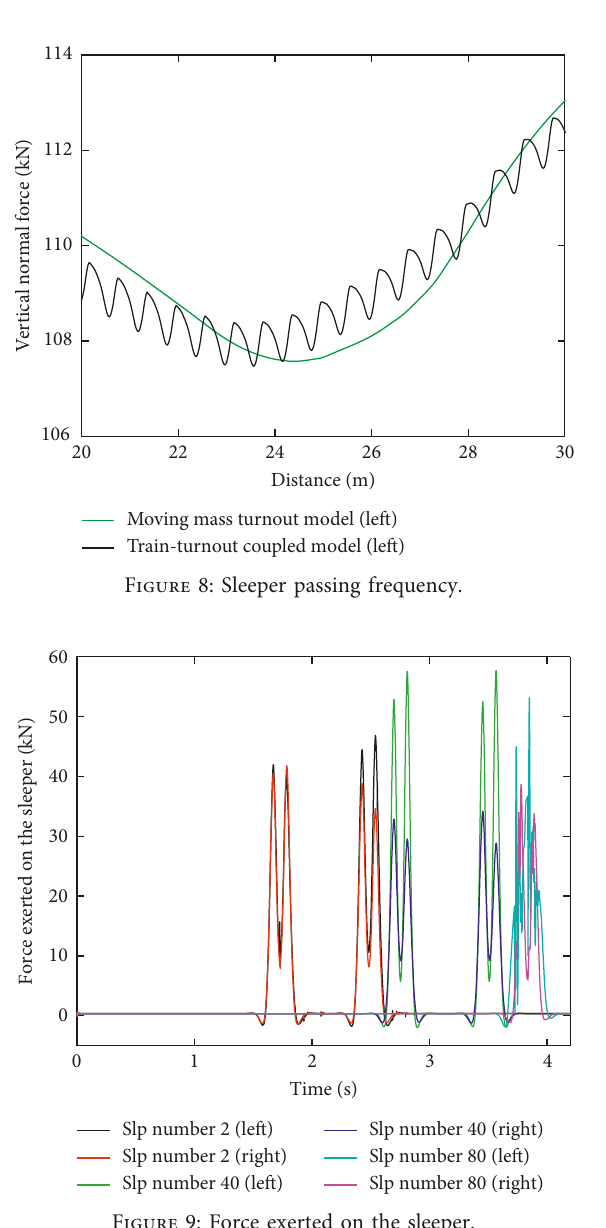
Figure 9: Force exerted on the sleeper.